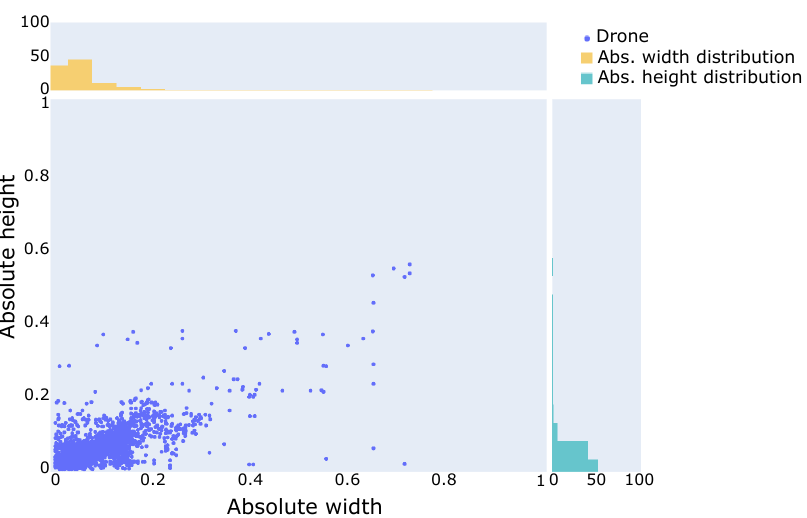
Figure 6. Dimension distribution for bounding boxes in the training